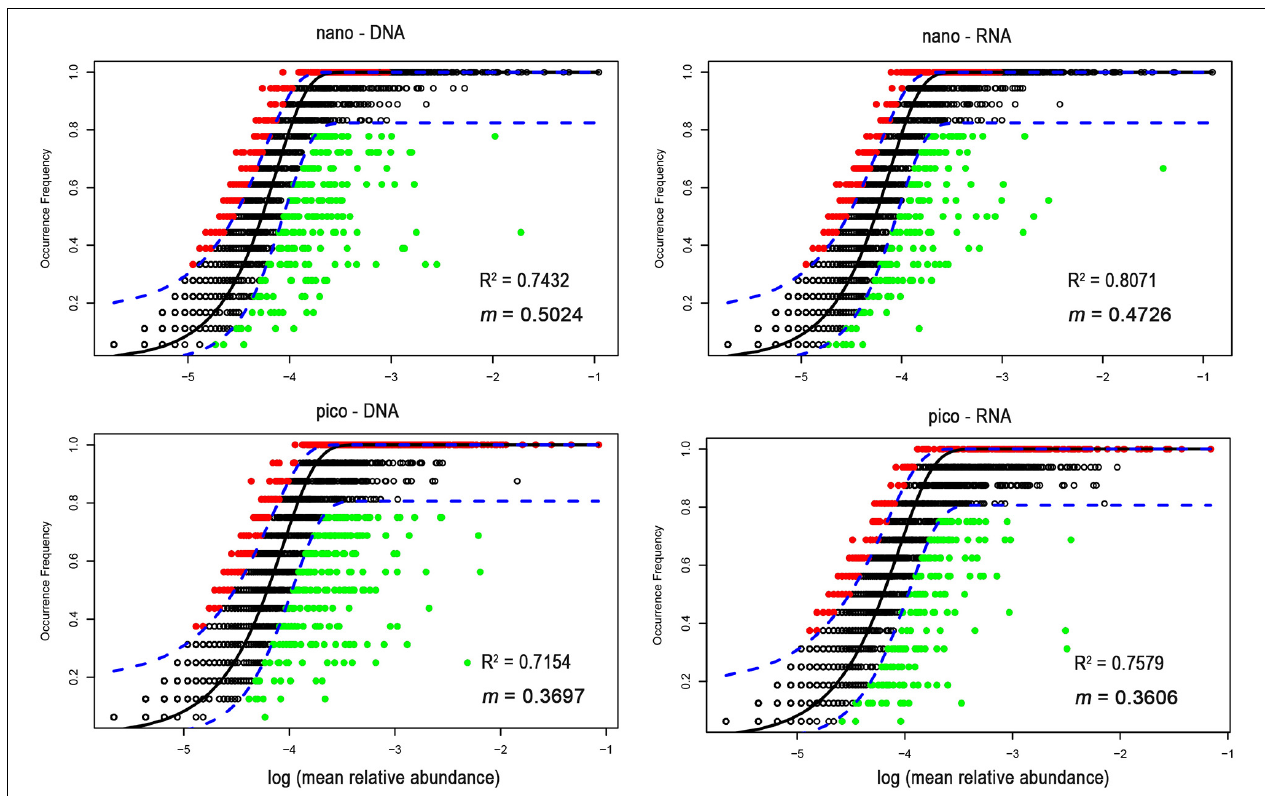
FIGURE 5 | The neutral community model based on the relationship between OTU occurrence and relative read abundance. OTUs with higher frequency than predicted by the model are shown in red, while those with lower frequency are shown in green. OTUs within the predicted range are displayed in black. The dotted line represents the 95% confidence interval (blue dotted line) around the model prediction.